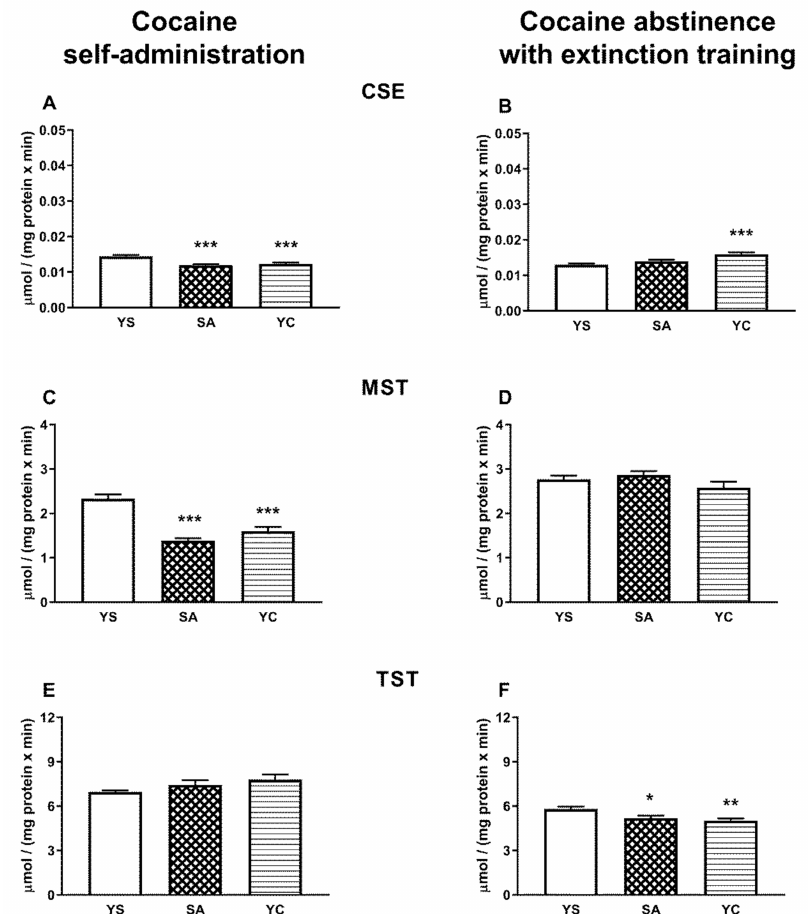
Figure 7. The activity of CSE, MST, and TST in the presence of cocaine ( A , C , E ) and after 10 days of drug abstinence with extinction training ( B , D , F ) in the kidneys of rats self-administering cocaine (SA), receiving passive cocaine infusion (YC), and receiving saline infusions (YS): data are presented as the mean ± SEM, n = 8–10 per group. * p < 0.05, ** p < 0.01, *** p < 0.001 vs. YS